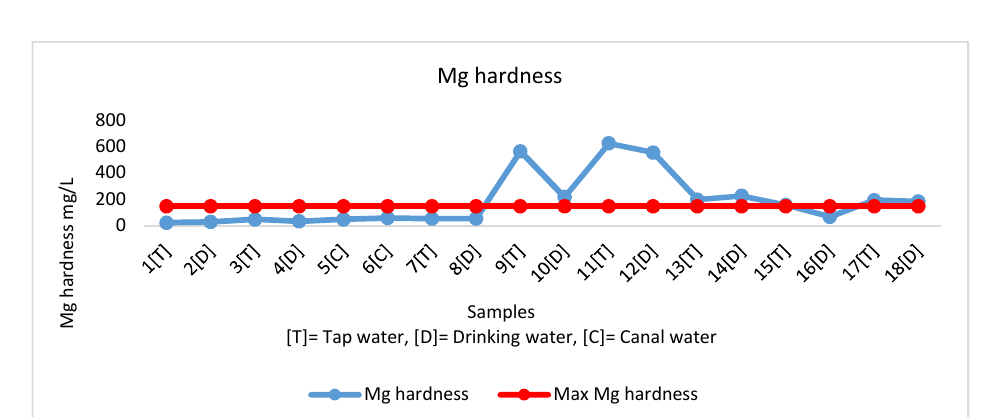
Fig. 7: Magnesium Hardness results of 18 Samples taken from 6 locations in Nawabshah City